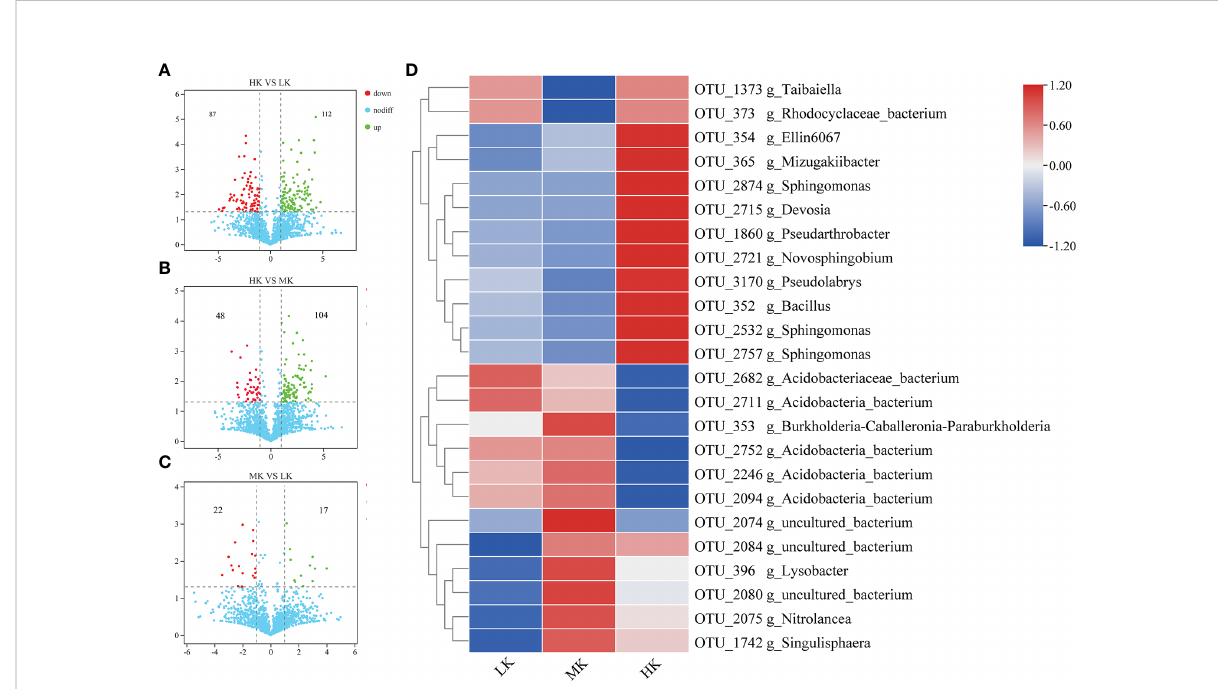
FIGURE 5 The relative abundance of enriched or depleted OTUs in different fertilized soils after pairwise comparison. (A-C) Volcano plot showing the differentially abundant OTUs between HK and LK, HK and MK, MK and LK. The position along the y-axis represents the log2 of average abundance of each OTU, and the x-axis represents the log2 of fold change between two groups. (D) Heatmap of the relative abundance of signi fi cantly enriched OTUs (top 30) among the different